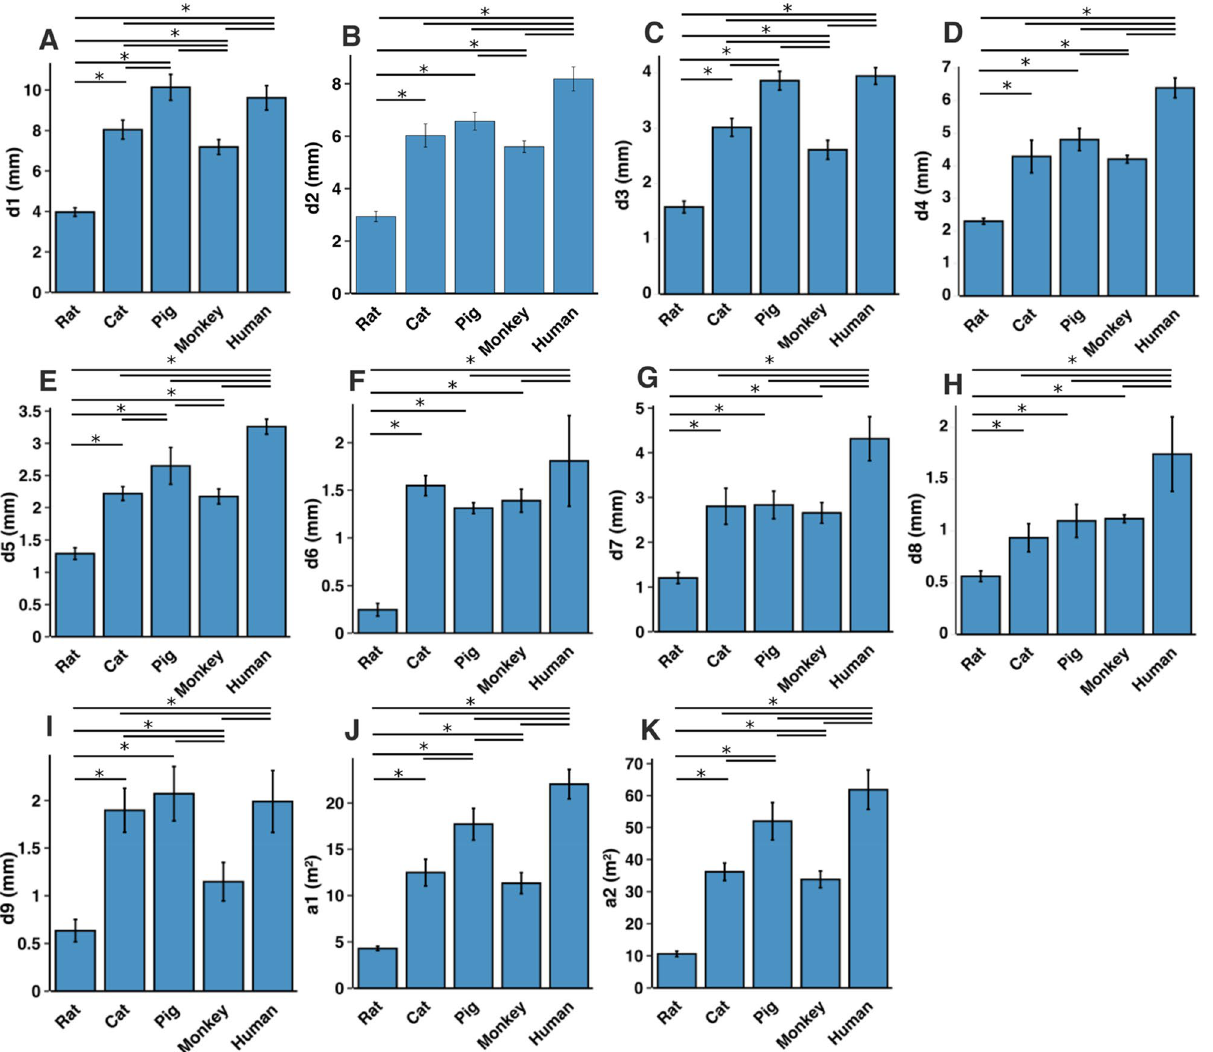
Figure 13. Comparison of the spinal cord dimensions and the locations of the dorsal and ventral horns in the spinal cords of rats, cats, pigs, monkeys, and humans. Graphs show the comparison of the values for each parameter at the Peak Cord Size (PCS) across species. Bars represent the mean and the error bars show the standard deviation of the mean. Parameters are those shown in Fig. 7 ( A ) d1. ( B ) d2. ( C ) d3. ( D ) d4. ( E ) d5. ( F ) d6. ( G ) d7. ( H ) d8. ( I ) d9. ( J ) a1. ( K )